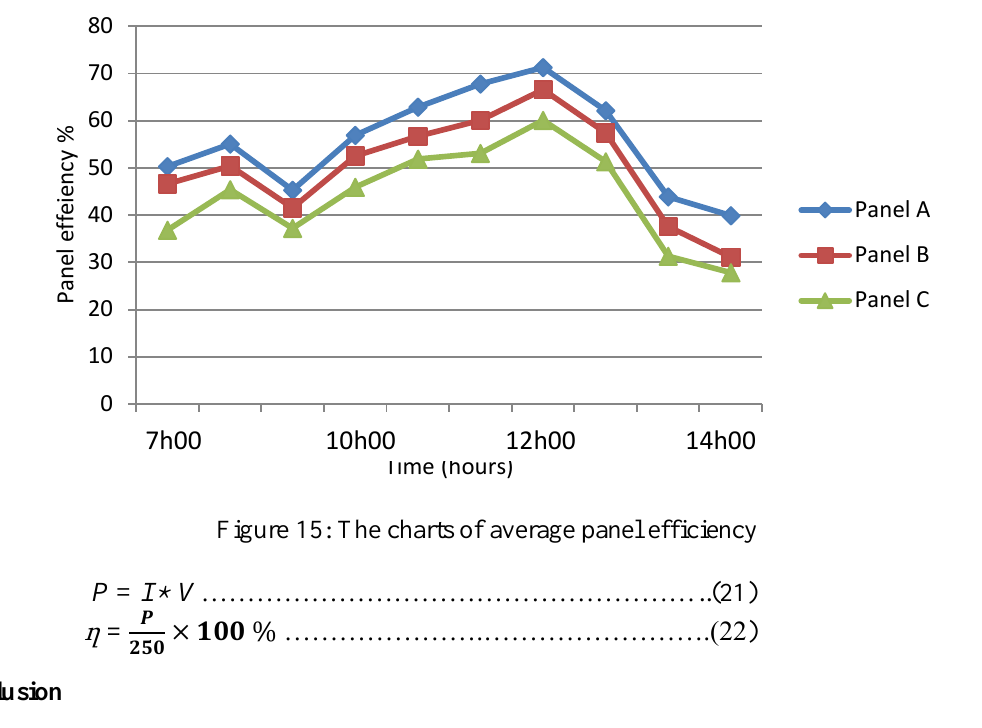
Figure 15: The charts of average panel